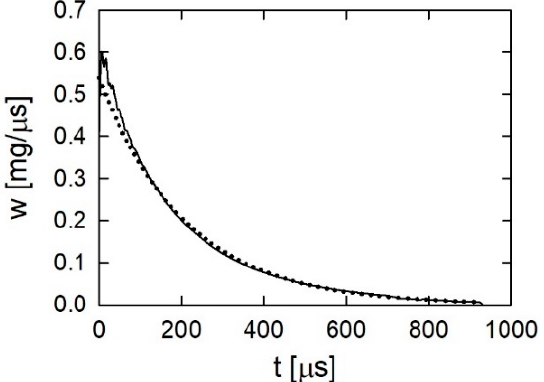
Figure 15. Changes in the flow intensity in the vent (solid line); exponential approximation (dotted